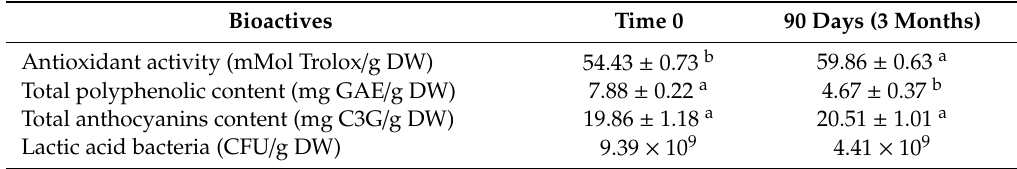
Table 1. Storage stability of co-microencapsulated bioactives.